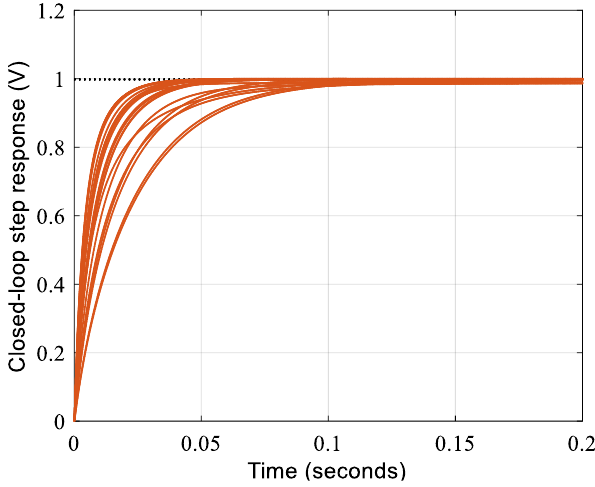
Figure 11. Step response of the closed loop system for a random selection of plant parameters.